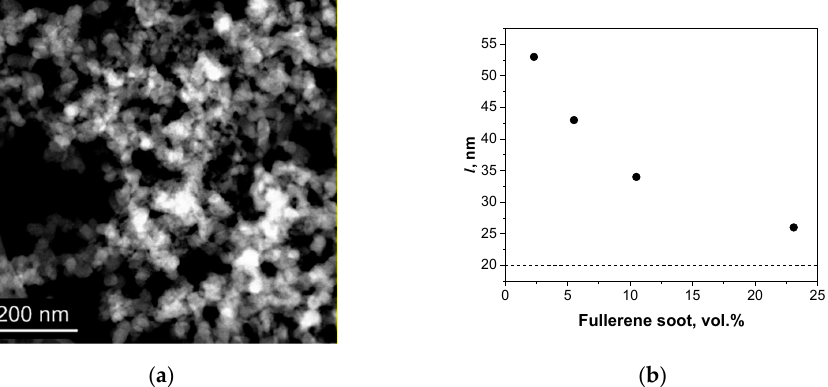
Figure 1. TEM image of fullerene soot ( a ), average distance ( l ) between strengthening particles in Cu-FS composite ( b ).